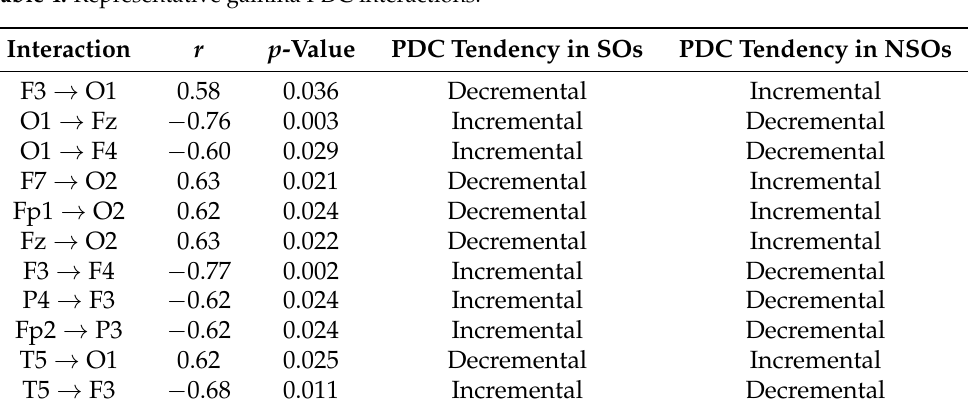
Table 4. Representative gamma PDC